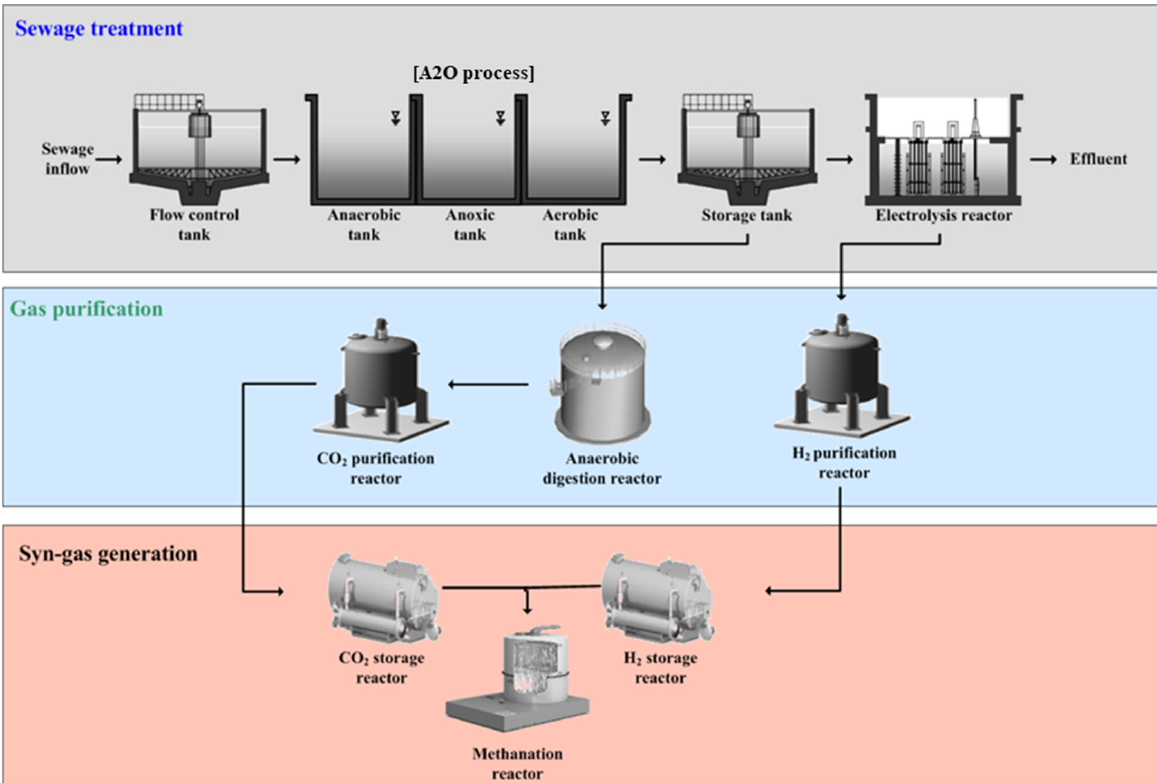
Figure 7. Process diagram of carbon resource integration.